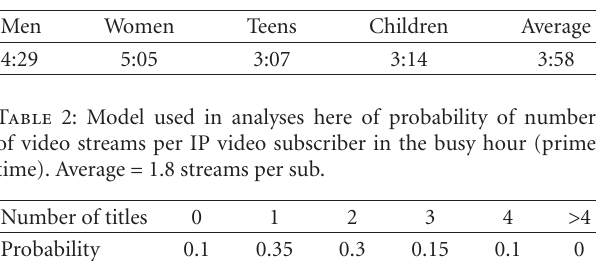
Table 1: TV viewing hours per day in 2003, FCC data.